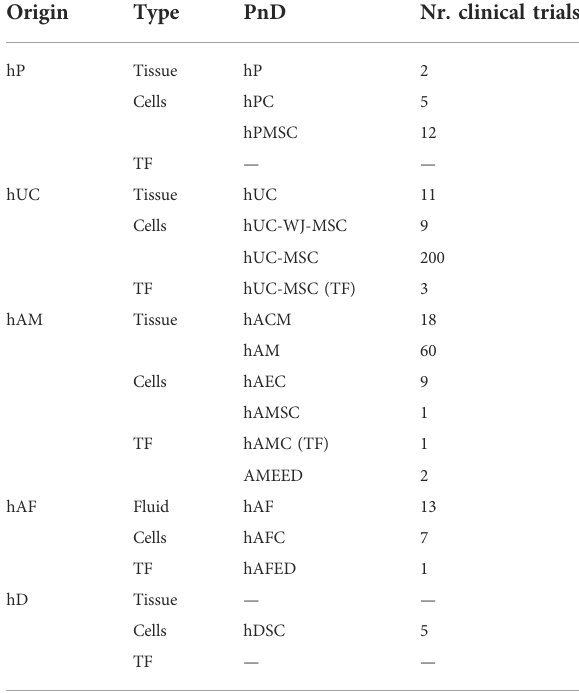
TABLE 1 PnD classi fi cation and number of clinical trials according to PnD and their perinatal